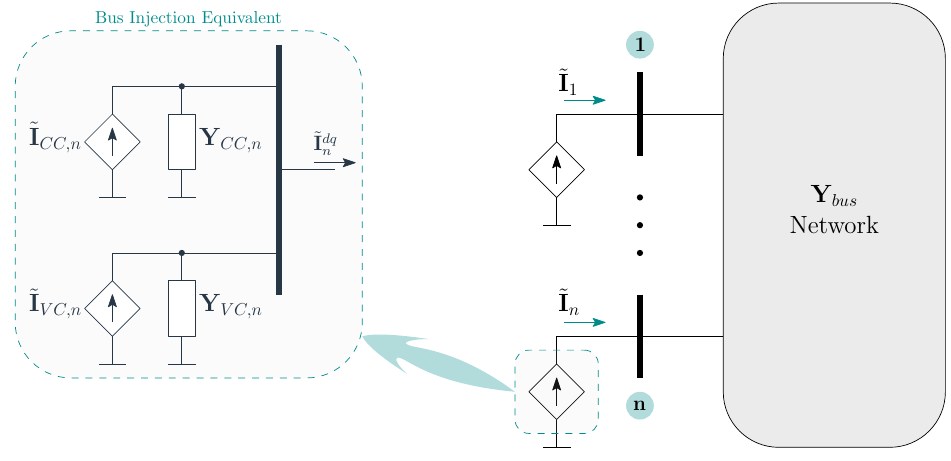
Figure 7. Generic inverter-populated power